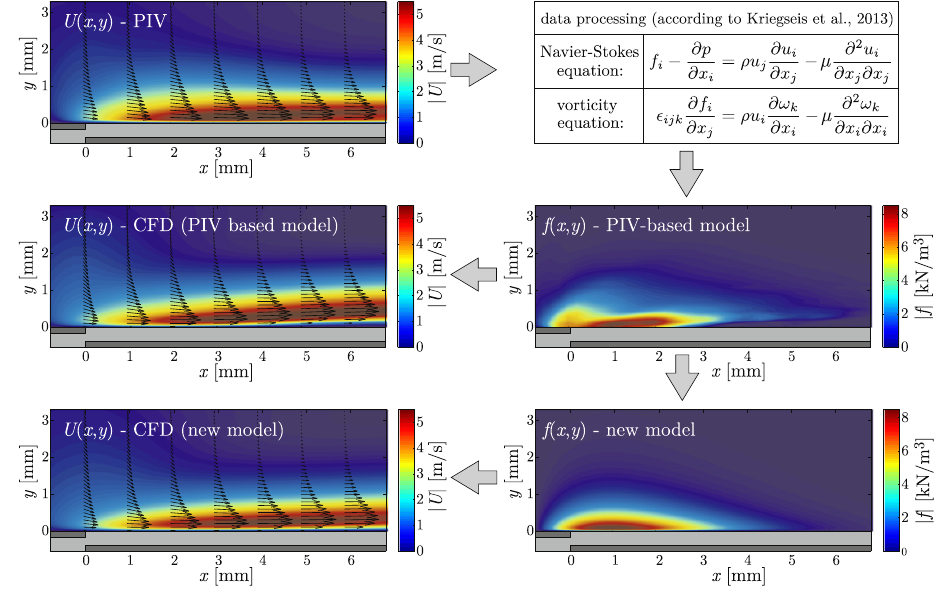
Fig. 3. Flowchart of the force determination procedure; PIV-based velocity field U ( x , y ) in proximity of the plasma actuator (top-left); resulting volume-force f ( x , y ) (middle- Figure 4. Electrohydrodynamic (EHD) force distribution derived from measurements of velocity right) and corresponding simulated velocity U ( x , y ) (middle-left); empirical force model f ( x , y ) (bottom-right) and corresponding velocity distribution U ( x , y ) (bottom-left).